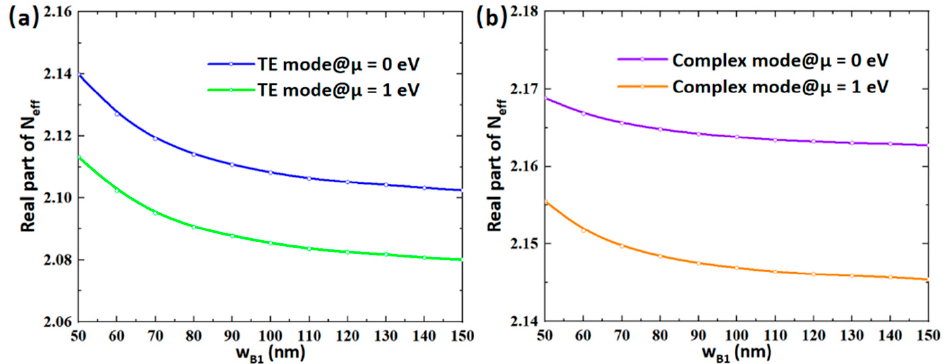
Figure 12. Re( N eff ) as a changing relationship of w B1 for ( a ) the TE mode and ( b ) the complex mode.